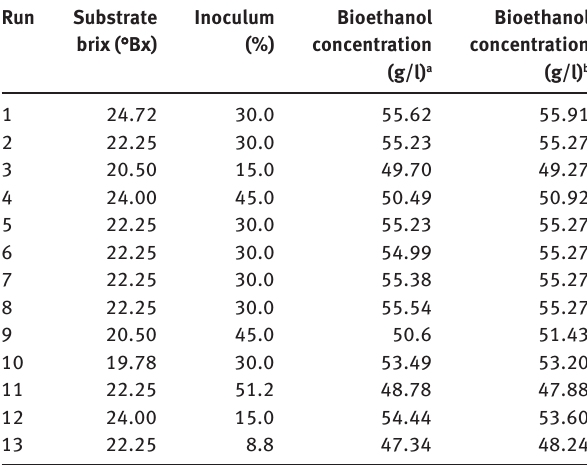
Table 2: Matrix of the CCD for bioethanol production using the SFO6 yeast.